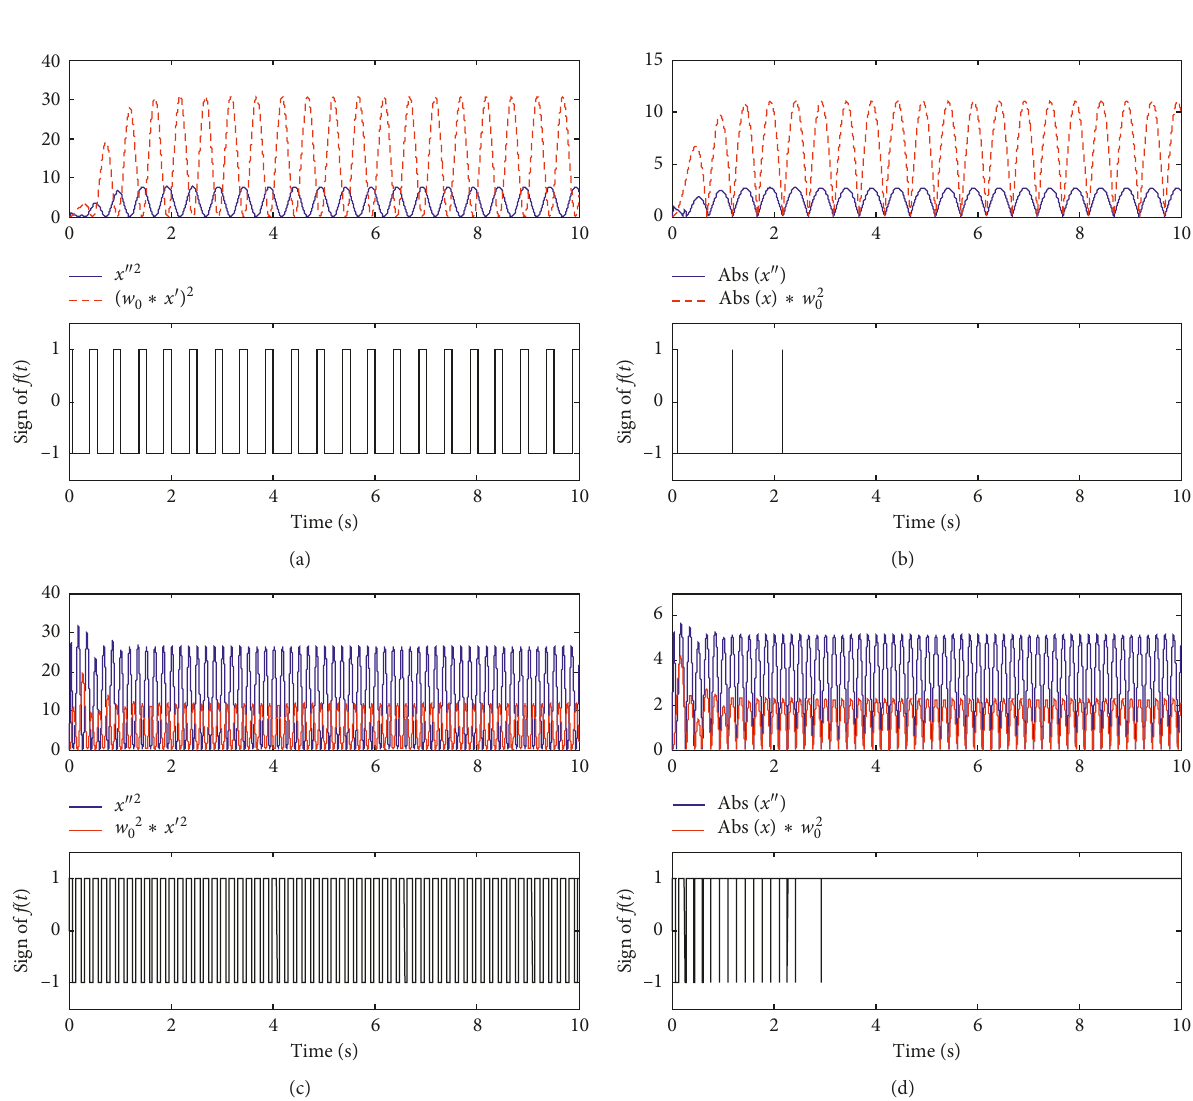
Figure 10: Results of frequency-range selector for passive suspension. Road excitation frequency of (a) 2 π , (b) 2 π , (c) 6 π , and (d) 6 π